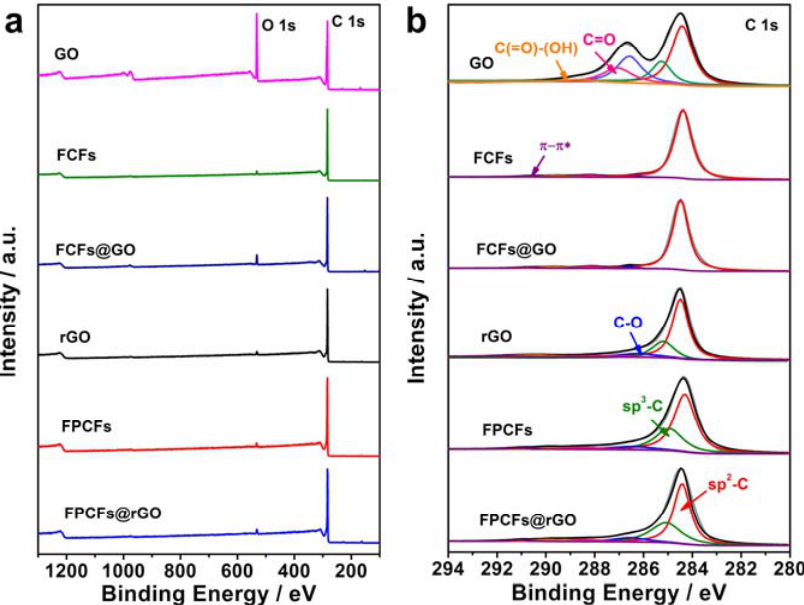
Figure 5. ( a ) Full survey XPS spectra and ( b ) high-resolution XPS spectra of C 1s of GO, FCFs,